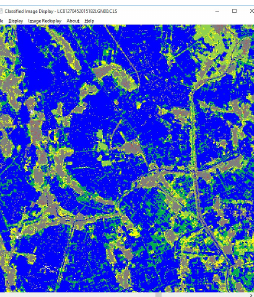
Figure 4. Good classification of small object by SSP concept. Example with Ngoc Son temple and Thap Rua of the Sword lake in Hanoi. Classified image (left) and image from the GoogleEarth (right) Figure 5 shows very fine classification of small pathways in crop field.